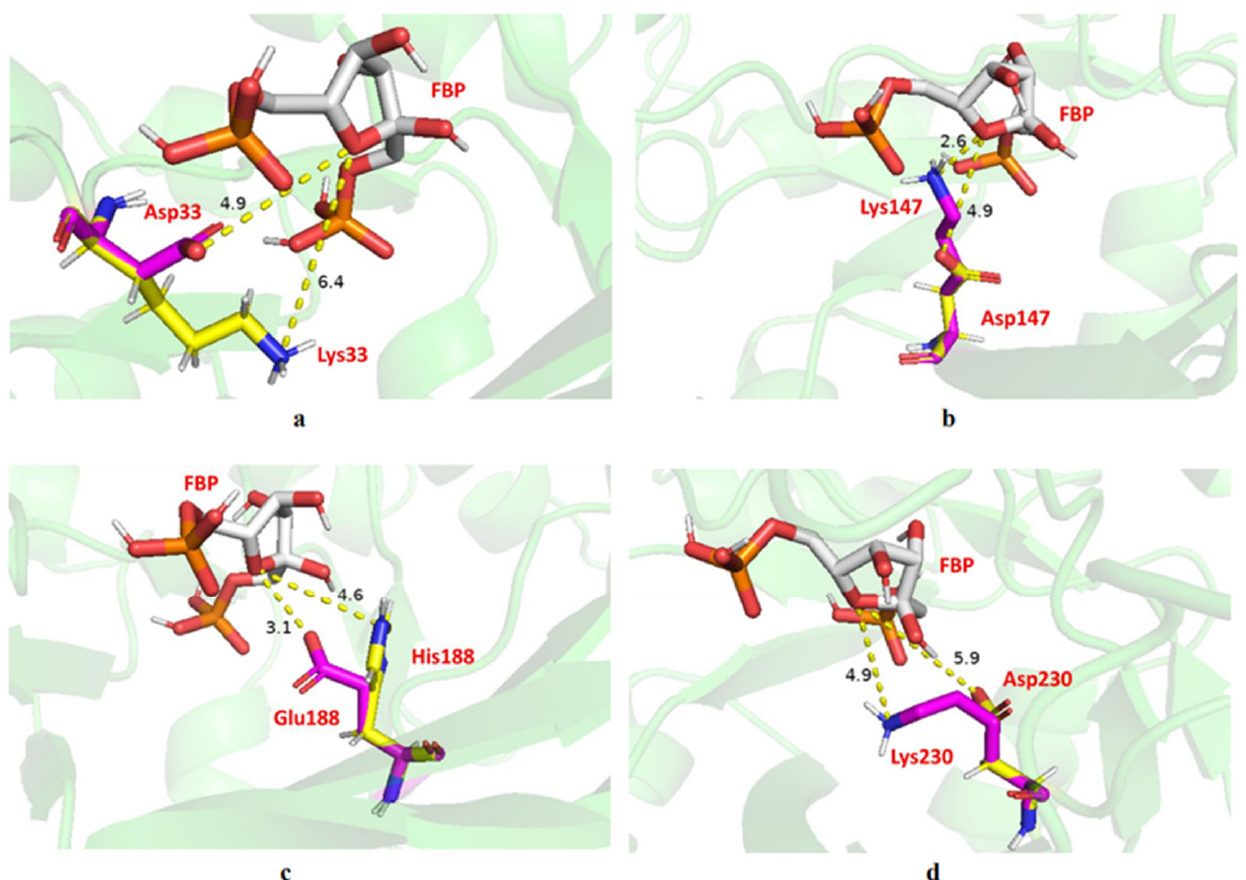
Figure 7. Substrate hydrogen-bonding simulation diagram. Yellow dashed lines represent the hy- drogen bonds interacting with the substrate fructose-1,6-bisphosphate (FBP), where Lys147 and Lys230 are hydrogen-bonded to the substrate.